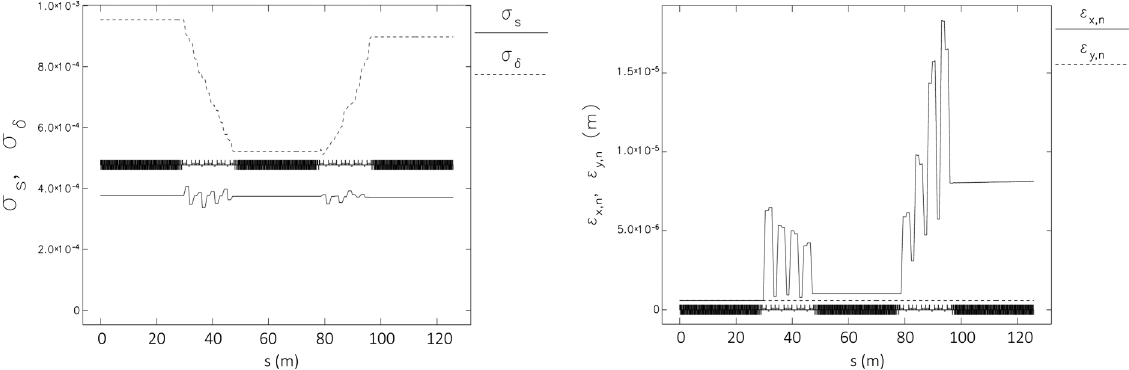
FIG. 9. Left: rms bunch length in meter and total rms fractional energy spread along RIBS, one turn. Right: transverse normalized rms emittances along RIBS, one